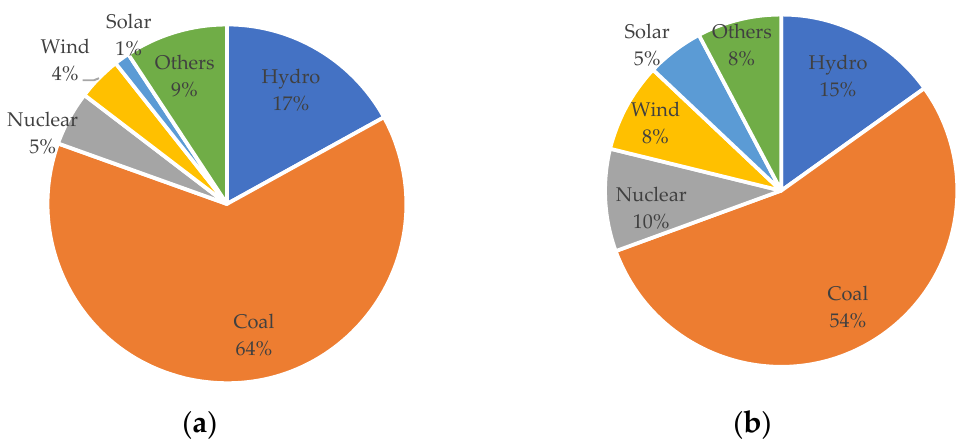
Figure 4. ( a ) The electricity profile of China in 2020; ( b ) The electricity profile of China in 2030.